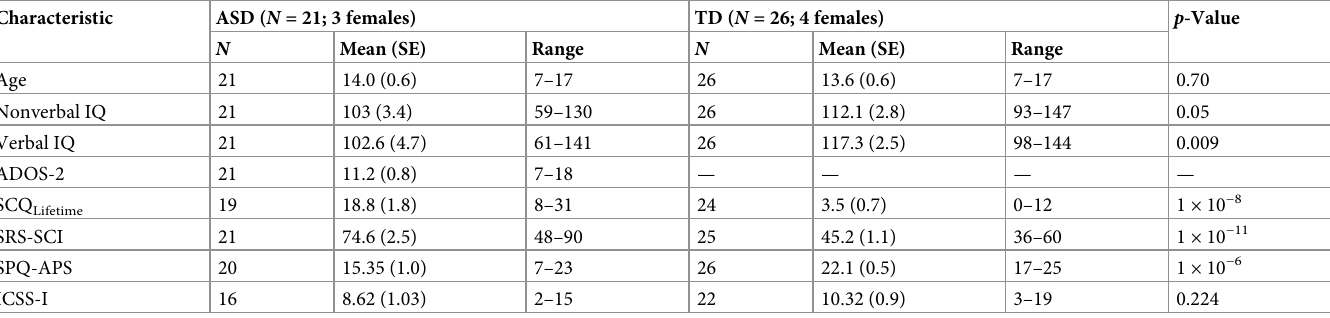
Table 1. Characterization of the